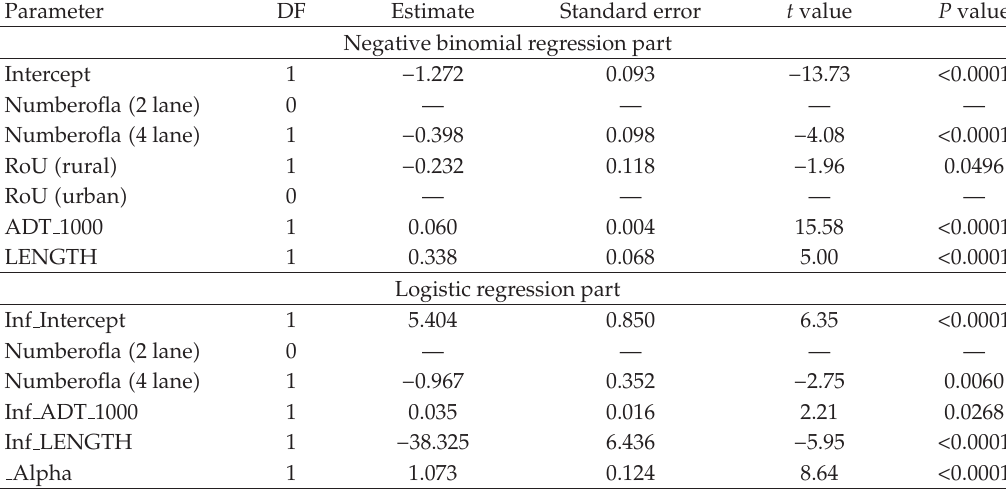
Table 5: Parameter estimates of ZINB model for injury and fatal crash